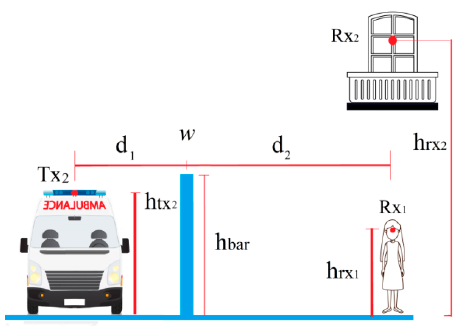
Figure 4. Siren vehicle configurations (‘3 ′ , person and ‘4 ′ , balcony).